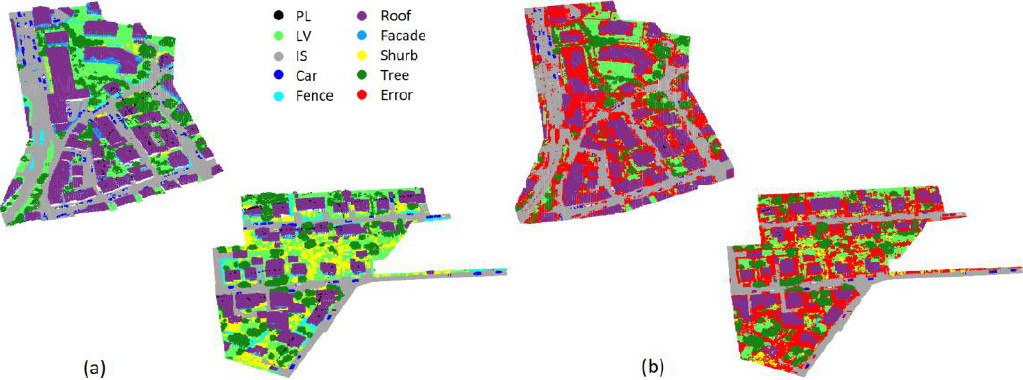
Figure 4. (a) Vaihingen test dataset with ground-truth labels, and (b) semantic segmentation results with error (false negative, red). Block size